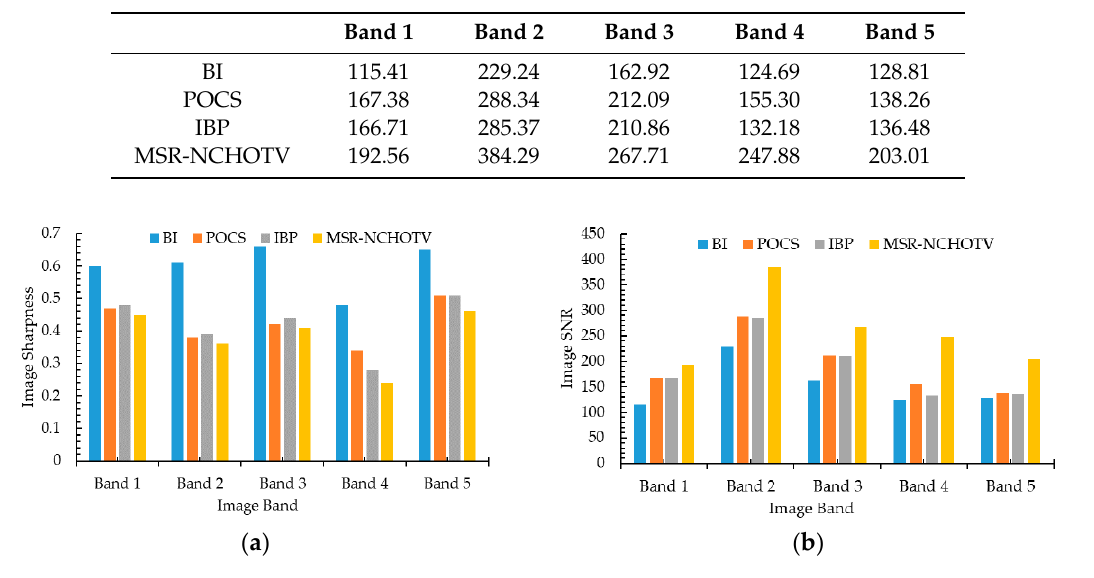
Table 3. Evaluation results for image signal-to-noise ratio (SNR).